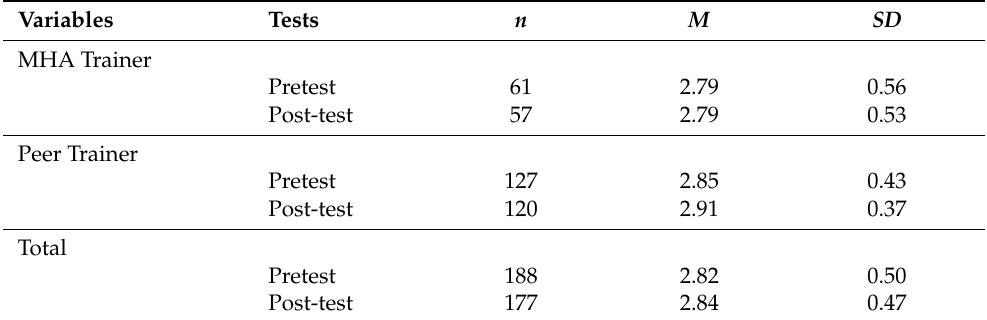
Table 9. Descriptive statistics for knowledge of trauma-informed educators’ roles ( n = 365). Variables